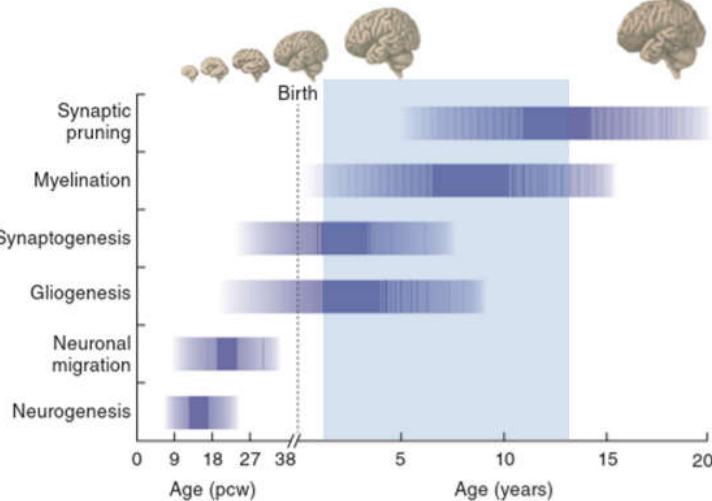
Figure 2. A timeline of human development during prenatal (in postconception weeks, pcw) and postnatal (in years) periods. The shaded horizontal bars represent the approximate timing of key neurobiological processes and developmental milestones. The light-blue overlay marks the period during which childhood-onset schizophrenia (COS) typically manifests. Gross anatomical features and the relative size of the brain at different stages are illustrated at the top. Adapted by Springer Nature (https://www.nature.com/nature/), Developmental timing and critical windows for the treatment of psychiatric disorders, Oscar Marín, 2016 [53].